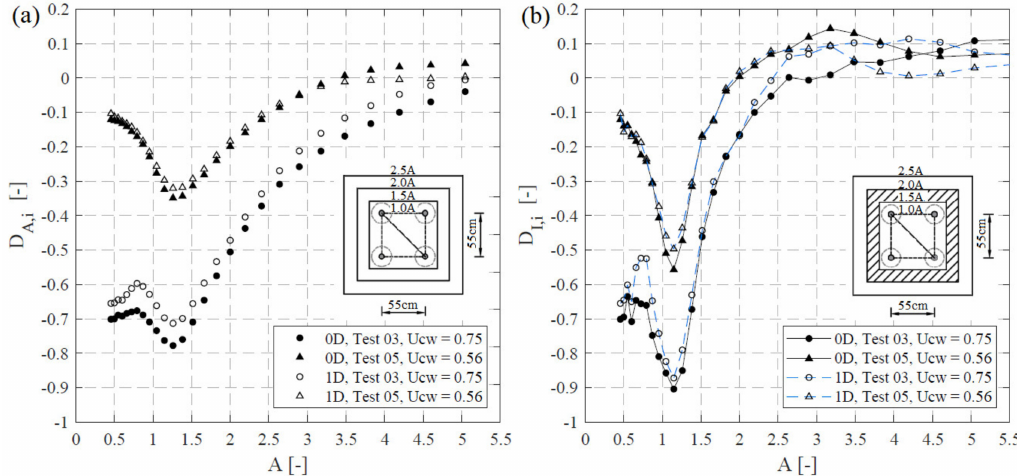
Figure 8. The cumulative ( D A , i ) ( a ) and incremental ( D I , i ) volume depth ( b ), calculated according Equations (4) and (5), as a function of the structure footprint distance A for Tests 3 and 5 for 0D and 1D node distances. While D A , i ( a ) is using the total interrogation area, D I , i ( b ) applies an incremental area (see shaded area as an